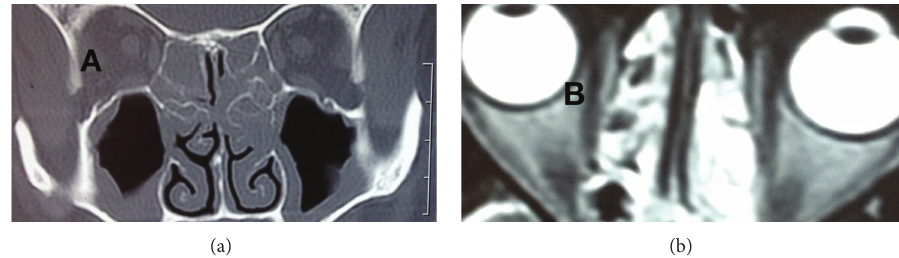
Figure 1: CT scan (a) and MRI scan (b) showing exuberant mucosal thickening of maxillary sinus and nose.